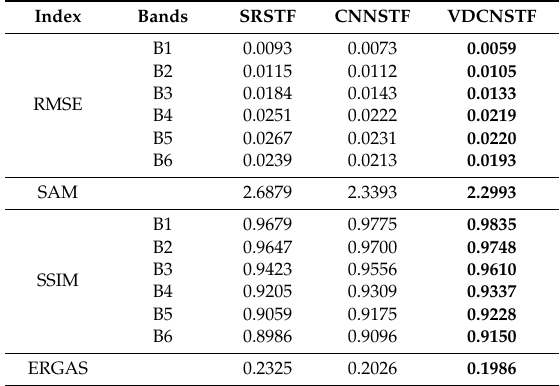
Figure 9. Fusion results on the 8th date of the LGC site. Top row shows the zoomed ground truth in the red rectangle of Figure 7e and the corresponding fusion results. Bottom row shows the zoomed ROIs in the black rectangle of images in the top row. ( a ) The ground truth Landsat image; ( b ) the fusion result of SRSTF; ( c ) the fusion result of CNNSTF; ( d ) the fusion result of VDCNSTF. Table 2. Quantitative evaluations of the fusion results in Figure 8. Bold fonts indicate better results.